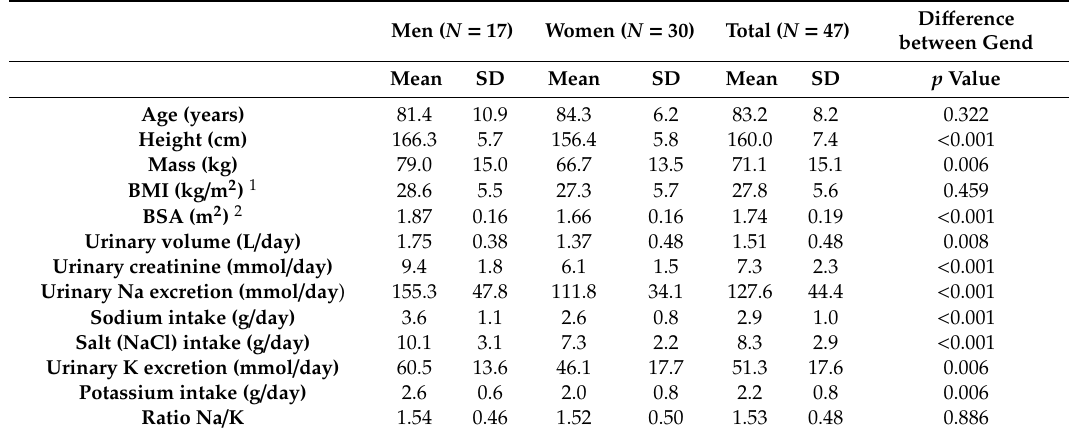
Table 1. Anthropometric characteristics and results of 24 h urinary sodium and potassium excretion in residents of retirement homes ( N = 47).